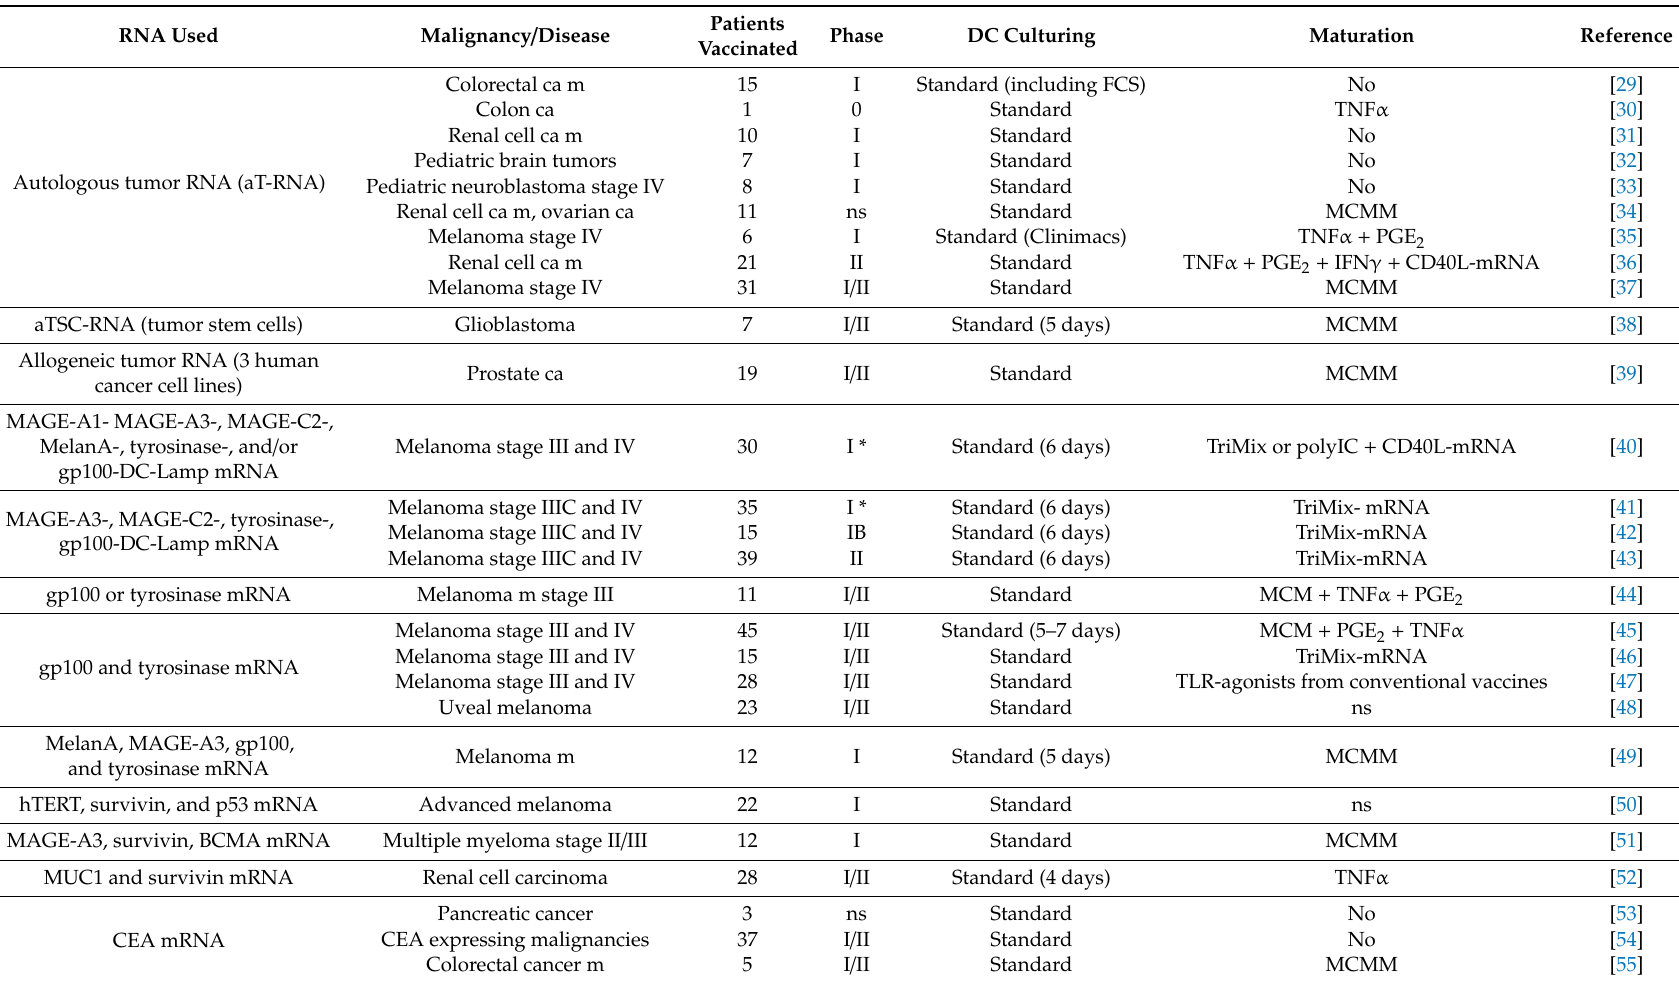
Table 1. Antigens and diseases treated with RNA-transfected